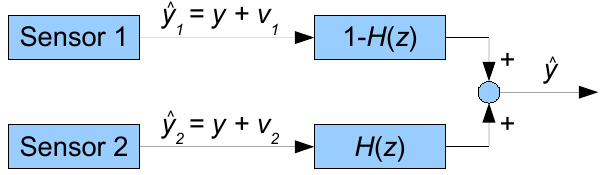
Figure 2: Complementary filters with two inputs. The figure is inspired by Brown and Hwang (1997, Figure